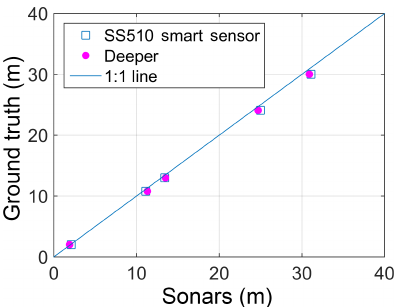
Figure 8. Relationship between measurements of two sonars and ground